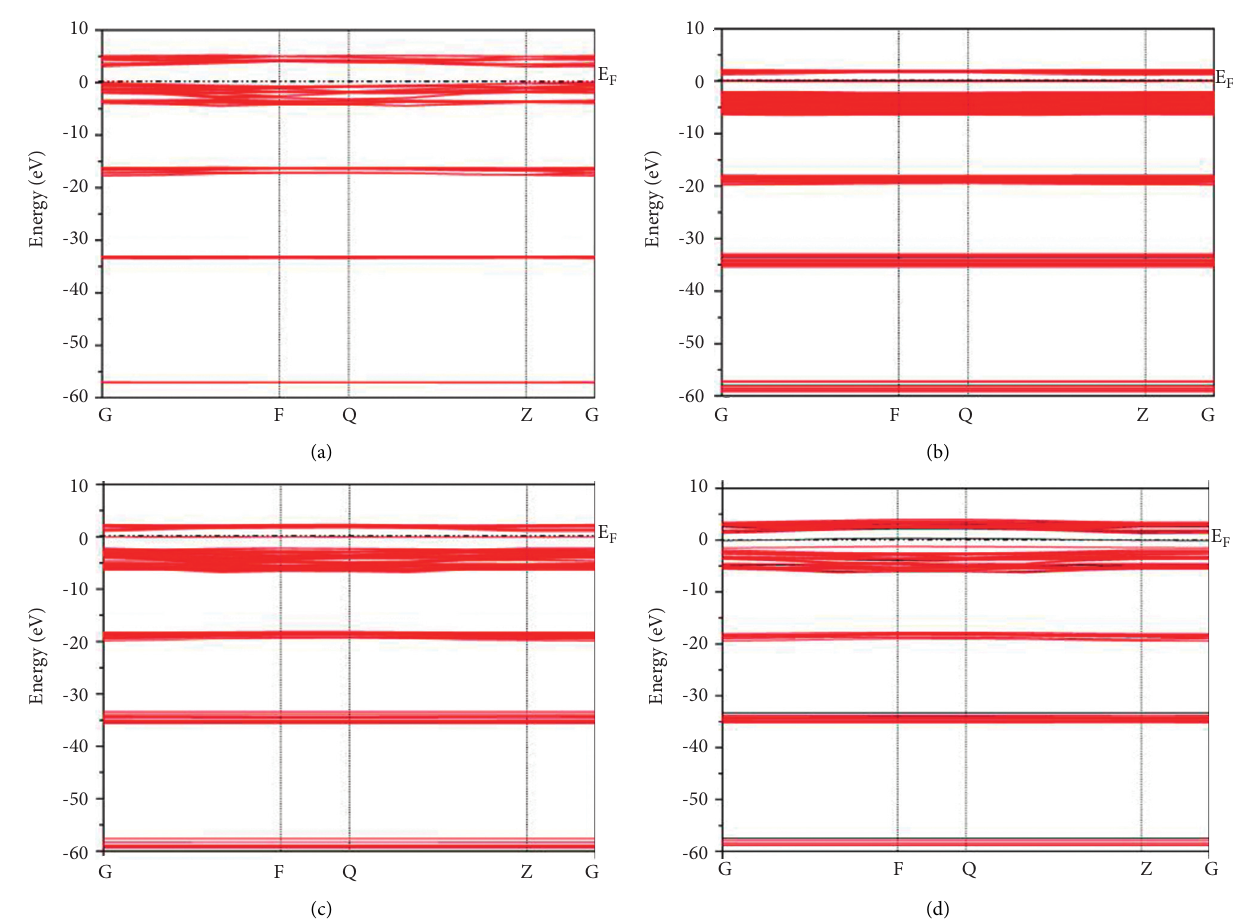
Figure 9: Full energy range band structure for anatase TiO 2 with oxygen defect contents of 0% (a), 3.125% (b), 6.25% (c), and 12.5%